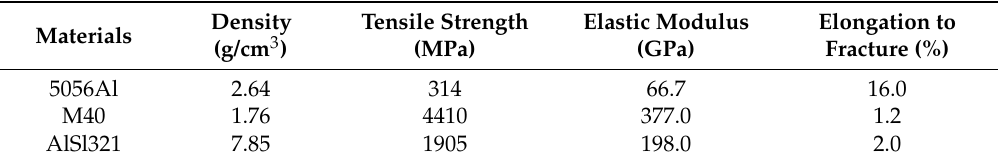
Table 1. Basic properties of 5056Al alloy, fibers and